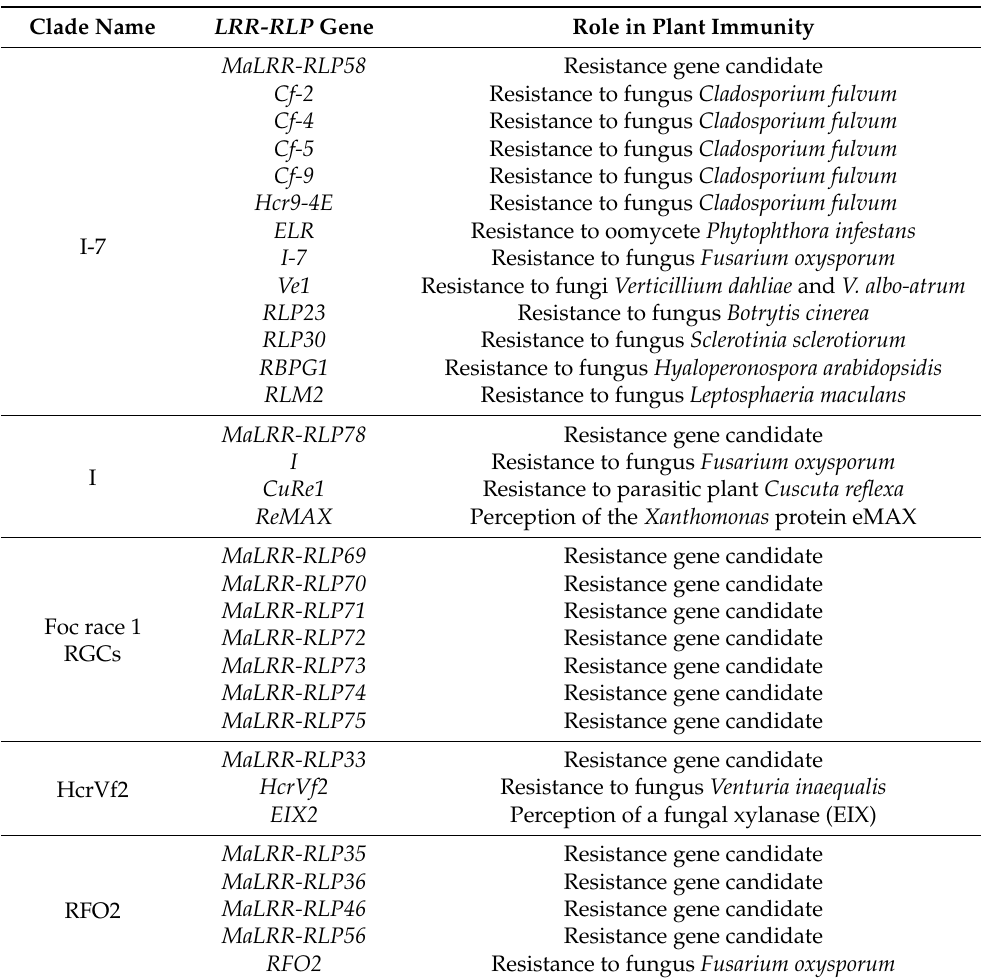
Table 3. Total number of banana LRR-RLPs proposed in this study as resistance gene candidates (in bold) based on their close phylogenetic relationships with known LRR-RLP genes and genetic mapping data of Foc race 1 resistance [48]. The role of known LRR-RLPs in plant immunity that are phylogenetically closely related to banana LRR-RLPs is shown. Additional information on LRR-RLP resistance genes is provided in Table